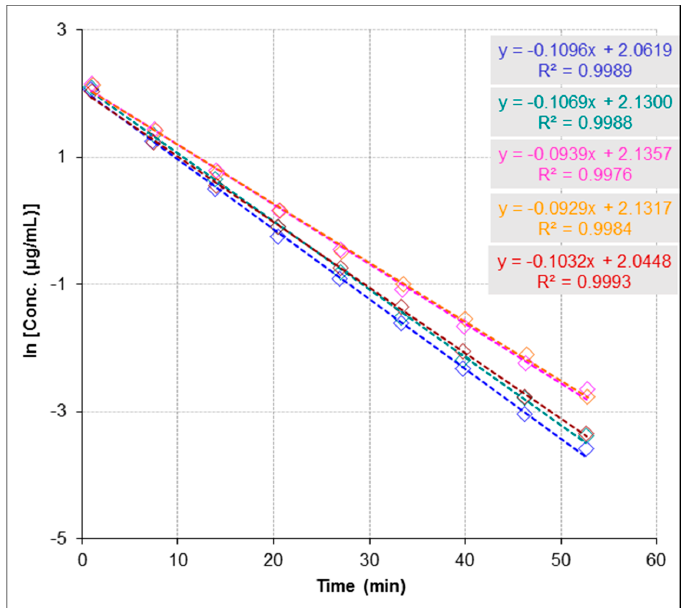
Figure 5. Determination of repeatability of measuring urease-catalyzed reaction evaluated by Electrospray Ionization-Mass Spectrometry (ESI-MS) based assay at fixed concentration of urea 416.4 µmol ∙ L − 1 and fixed concentration of urease 60.0 µg ∙ mL − 1 (repeated five times; as shown in different colors). Relative standard deviation (RSD) of slopes is 7.5%.